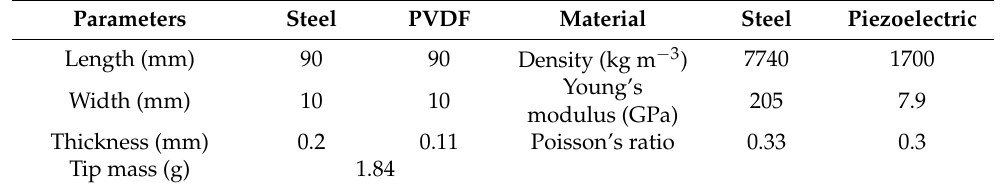
Table 1. Material and geometric parameters of the harvester utilized for experimental validation. Parameters